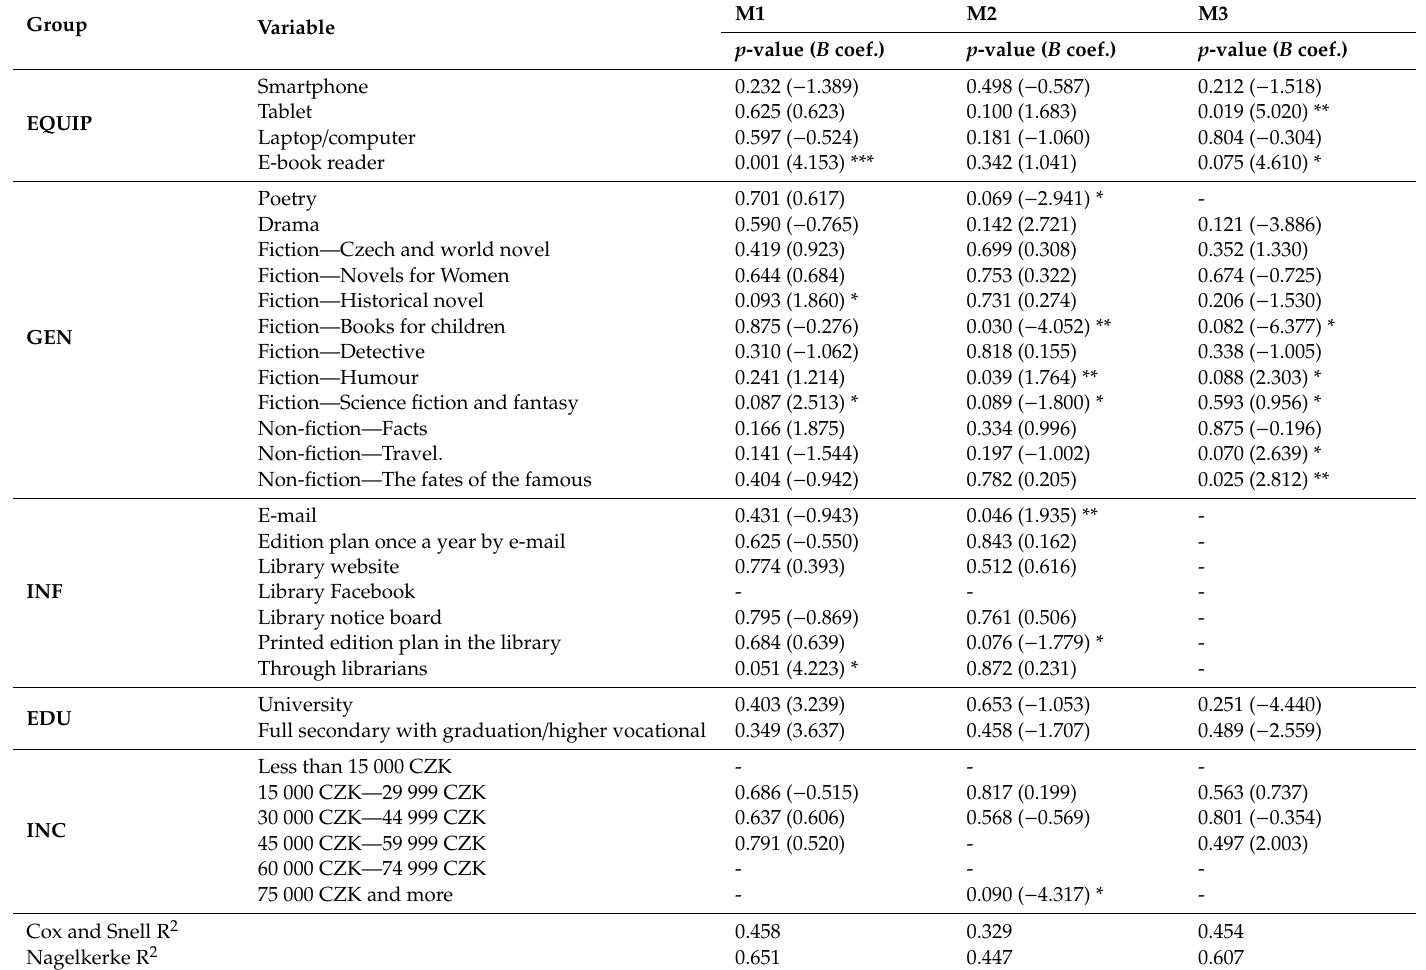
Table 5. The readers of e-books: